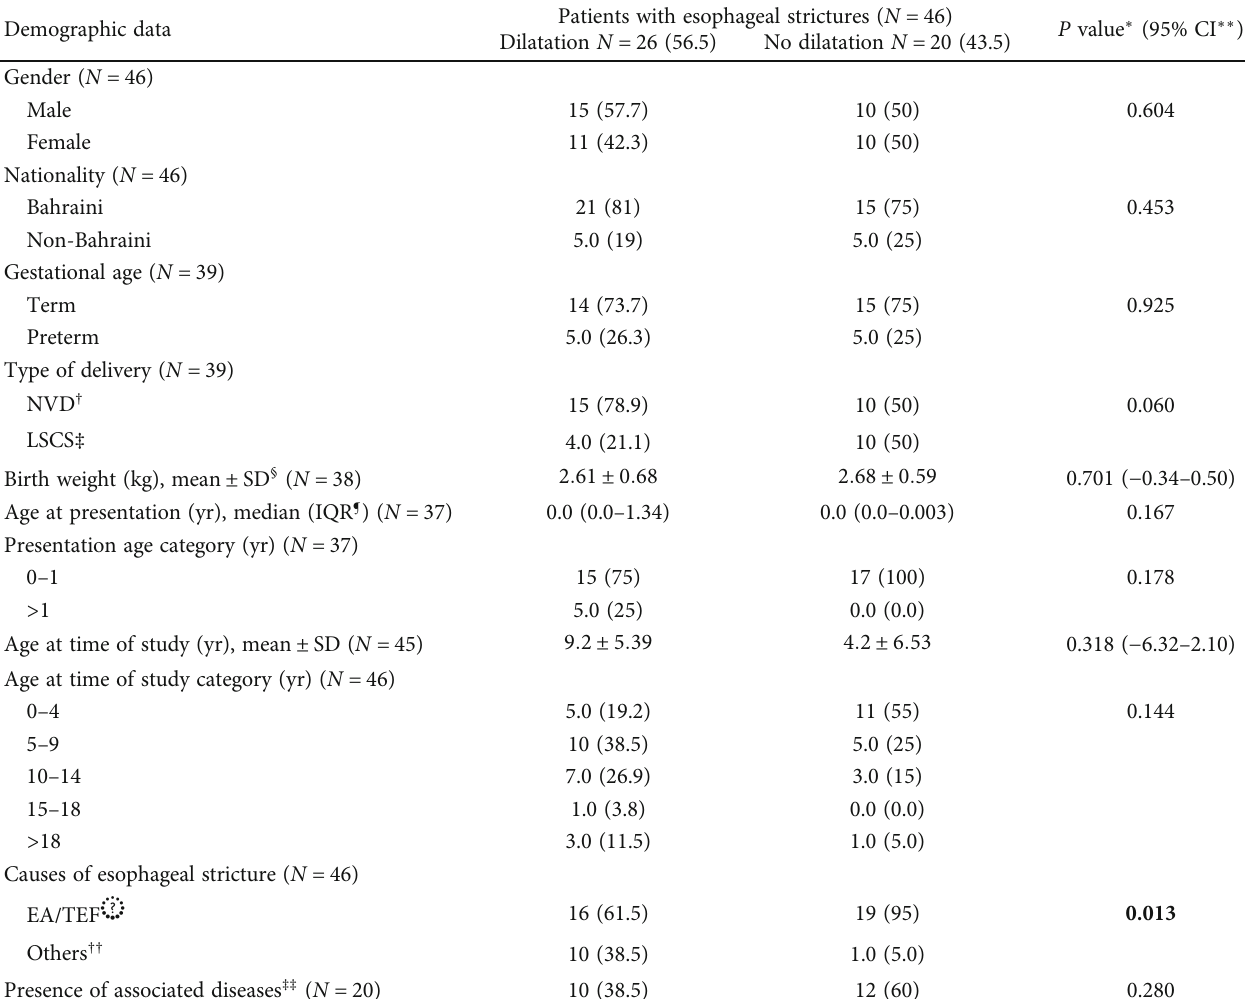
Table 1: Demographic data of 46 children with esophageal strictures with or without endoscopic esophageal dilatation. Demographic